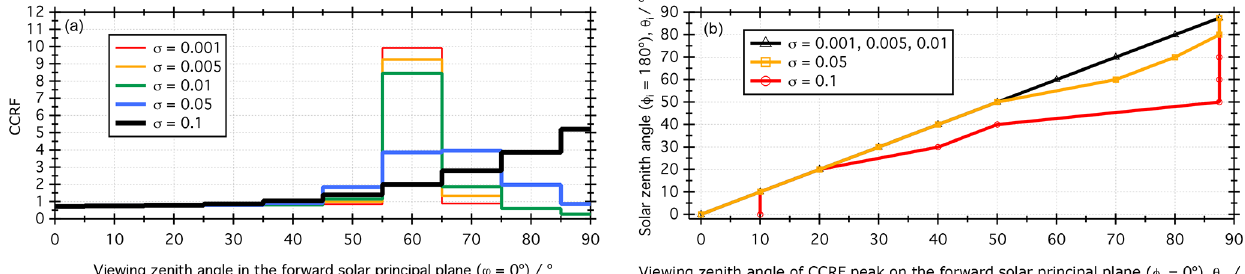
Figure 5. The effects of roughness on the forward-scattering peak of the CCRF. (a) CCRF in the forward solar principal plane ( φ r = 0 ◦ ) of optically thick first-year sea ice, modelled with a solar zenith angle of θ i = 60 ◦ as a function of surface roughness. (b) Location of the CCRF peak of optically thick first-year sea ice on the forward solar principal plane ( φ r = 0 ◦ ) as a function of solar zenith angle, θ i , for different surface roughness